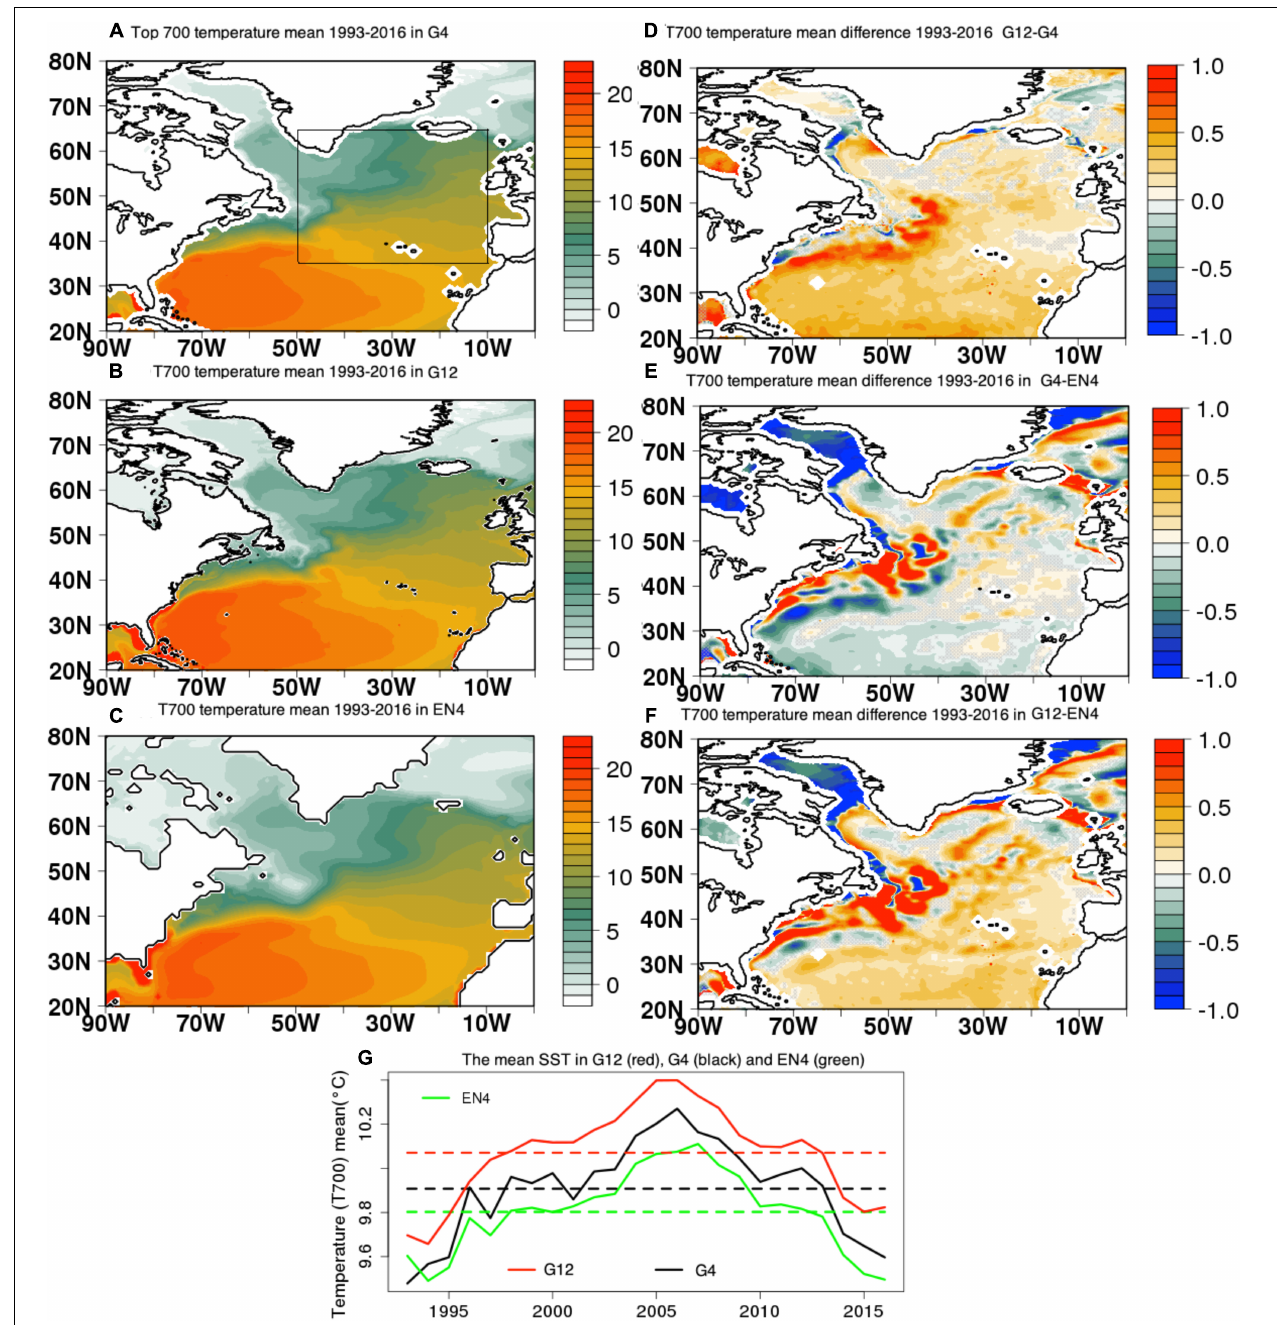
FIGURE 1 | The mean climatology of top 700 m (T700) temperature computed for the 1993–2016 period (A) in G4, (B) in G12, (C) in EN4, (D) the difference between G12 and G4, (E) the difference between G4 and EN4, (F) the difference between G12 and EN4, (G) The T700 averaged in the box area shown in panel (A) . Areas with differences that do not pass t -test 95% confidence interval are marked with light gray